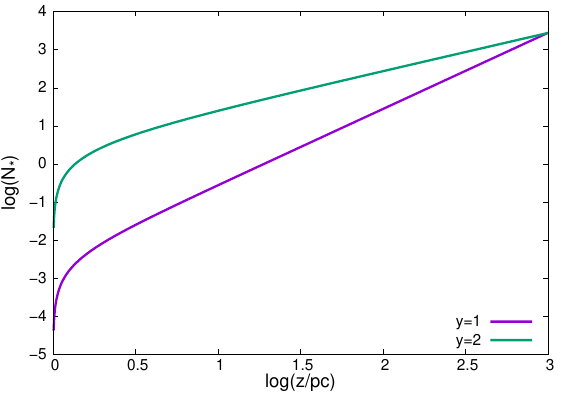
Figure 2. Cumulative number of stars inside a jet with opening angle θ = 5 ◦ for a black hole of M BH = 10 8 M ⊙ and an accretion e ffi ciency η accr = 0 . 1. The 0 . 1 N ⋆ are considered to be WR